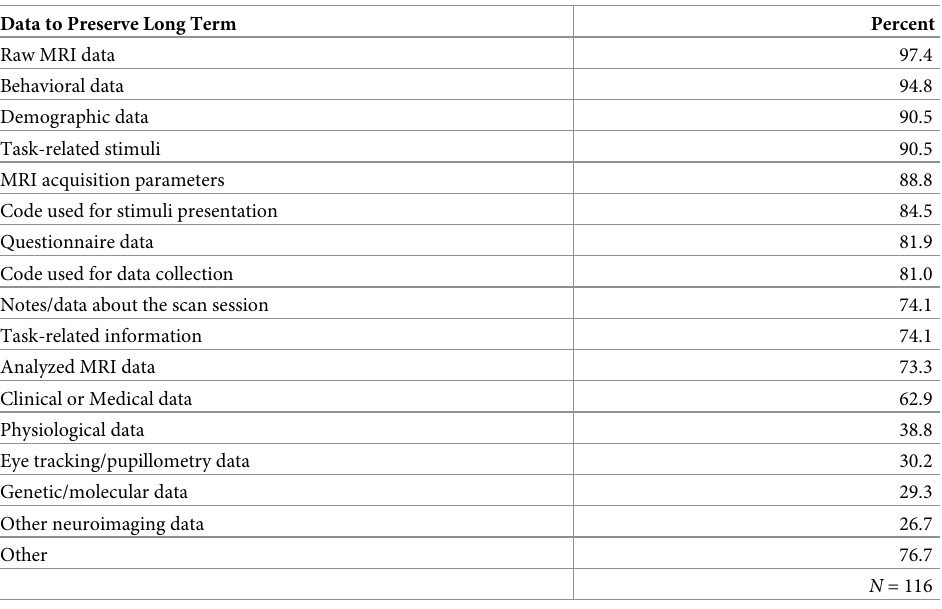
Table 6. Important parts of data to preserve long